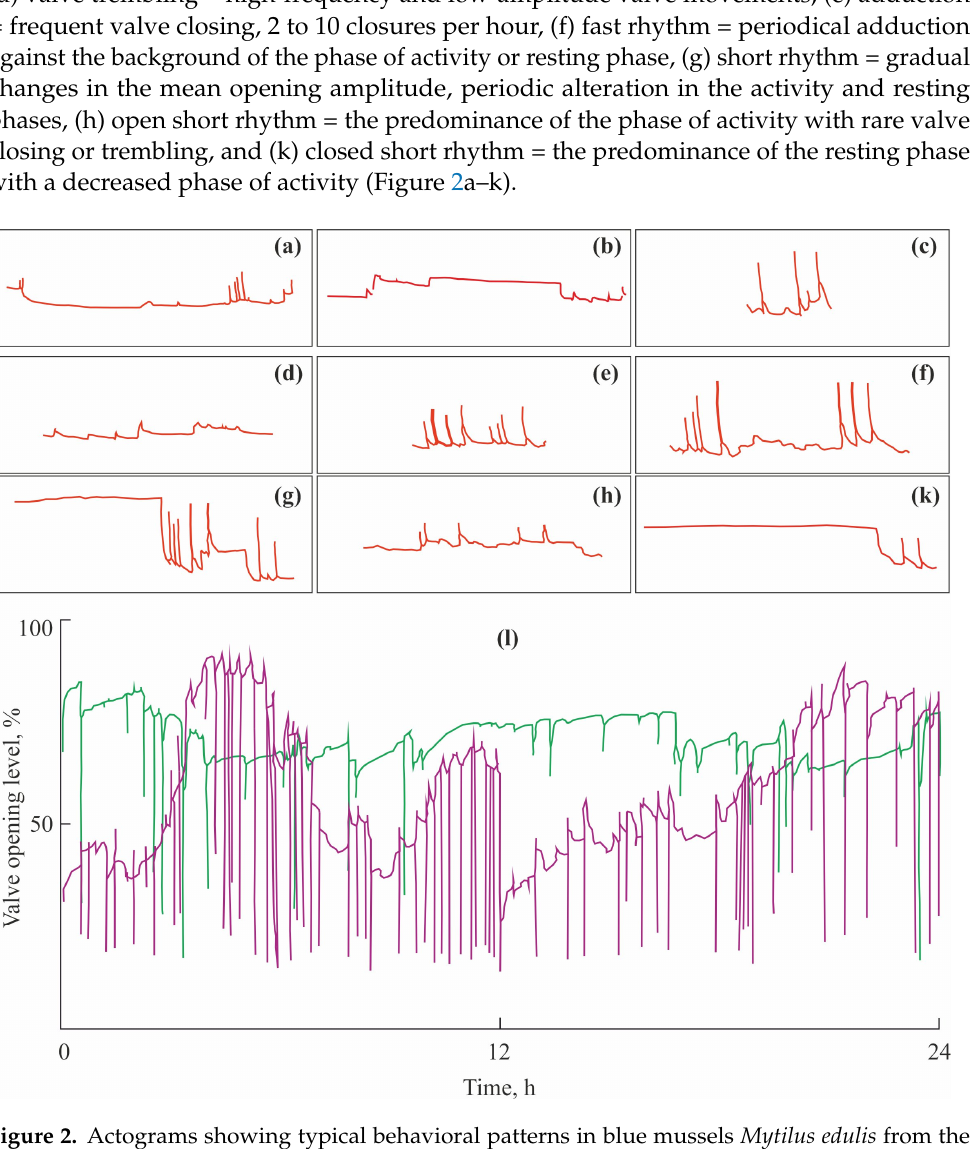
Figure 2. Actograms showing typical behavioral patterns in blue mussels Mytilus edulis from the Barents Sea: ( a ) phase of activity, ( b ) resting phase, ( c ) valve closing, ( d ) valve trembling, ( e ) adduction, ( f ) fast rhythm, ( g ) short rhythm, ( h ) open short rhythm, ( k ) closed short rhythm, and ( l ) typical records of valve activity under normal (green) and stress conditions (violet). Modified from